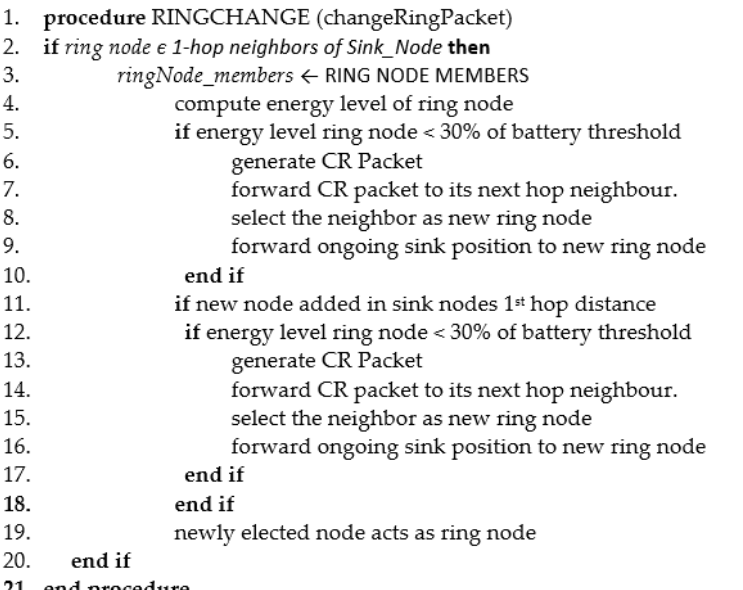
Figure 10. Pseudo code of the ring change